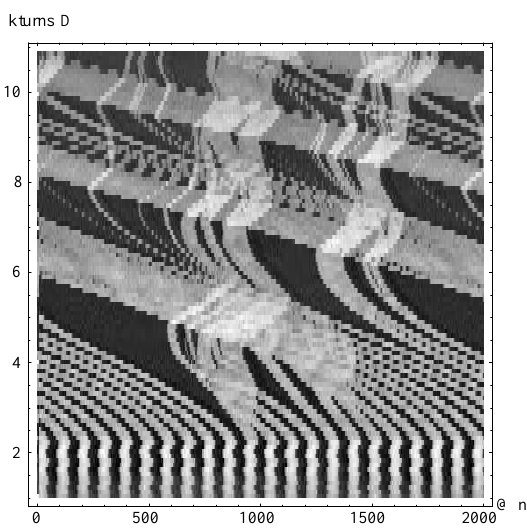
FIG. 11. 1.8 3 10 12 protons, one trace each 100 turns, vertical span 16.7 ms, V rf (cid:1) 0.6 kV.